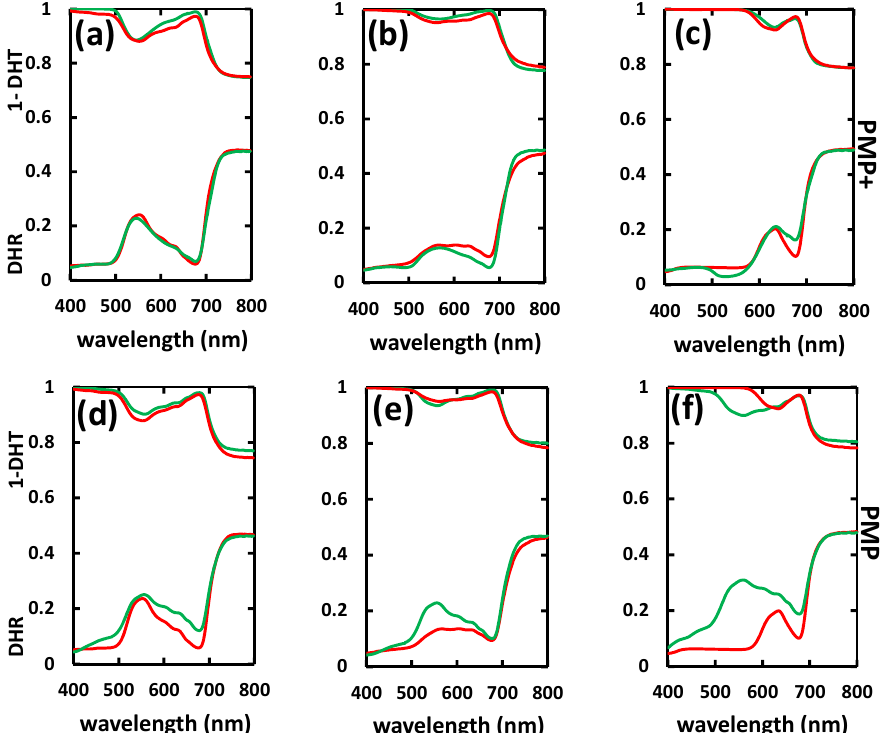
Figure 6. Comparison of measured (red) and simulated (blue) reflectance and transmittance spectra for the different Ants content leaves from PROSPECT-MP+ (PMP+) and PROSPECT-MP (PMP), in which ( a , d ) from the low, ( b , e ) from the medium, and ( c , f ) high from the high. DHR and DHT are leaf directional hemispherical reflectance and transmittance, respectively.